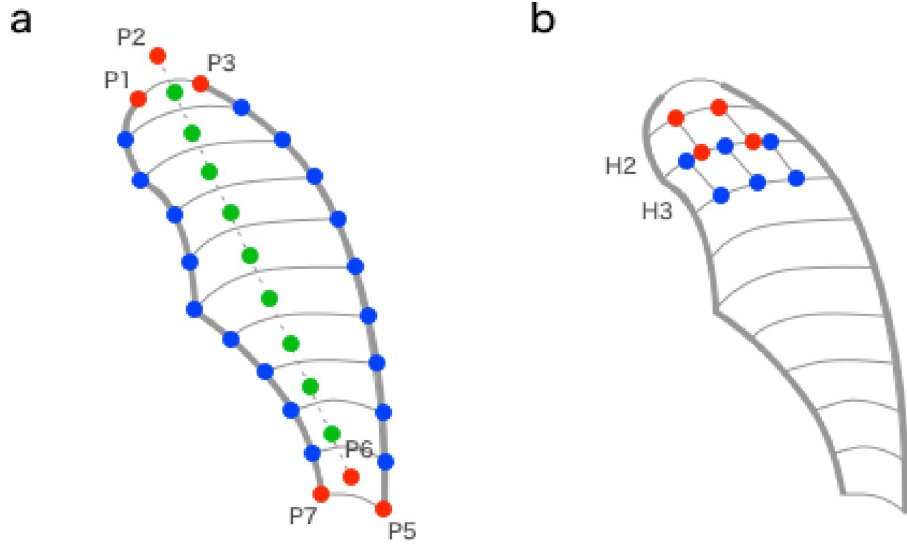
Fig 3. Segmentation of the